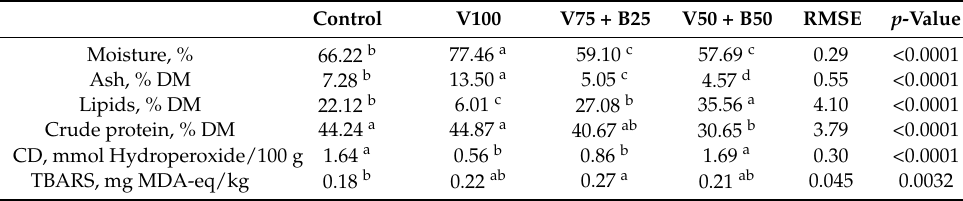
Table 7. Black soldier fly larvae chemical composition and oxidative